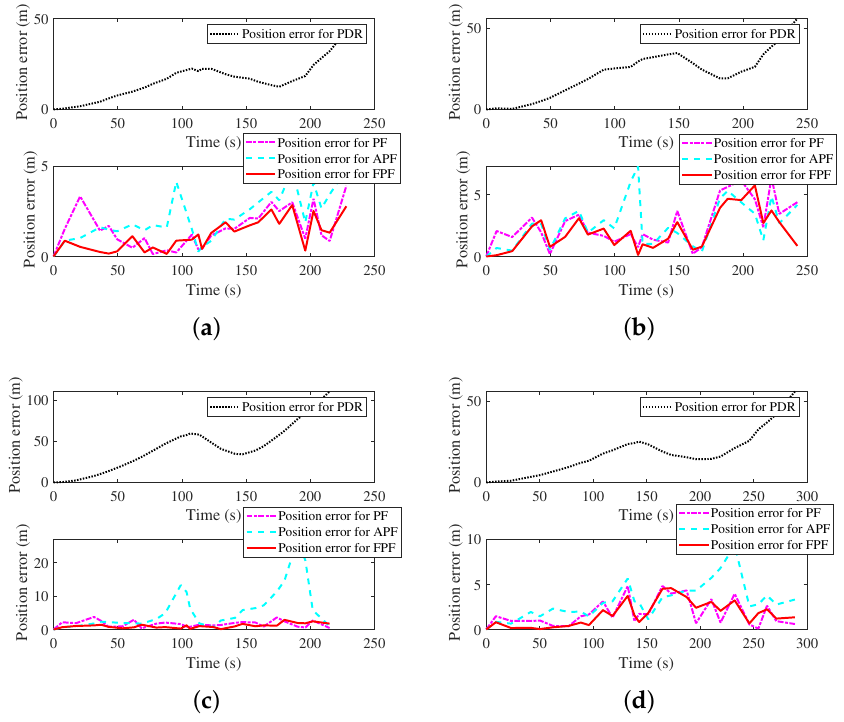
Figure 13. Position errors with different modes. ( a ) Position errors with calling mode. ( b ) Position errors with dangling mode. ( c ) Position errors with handheld mode. ( d ) Position errors with pocketed mode.